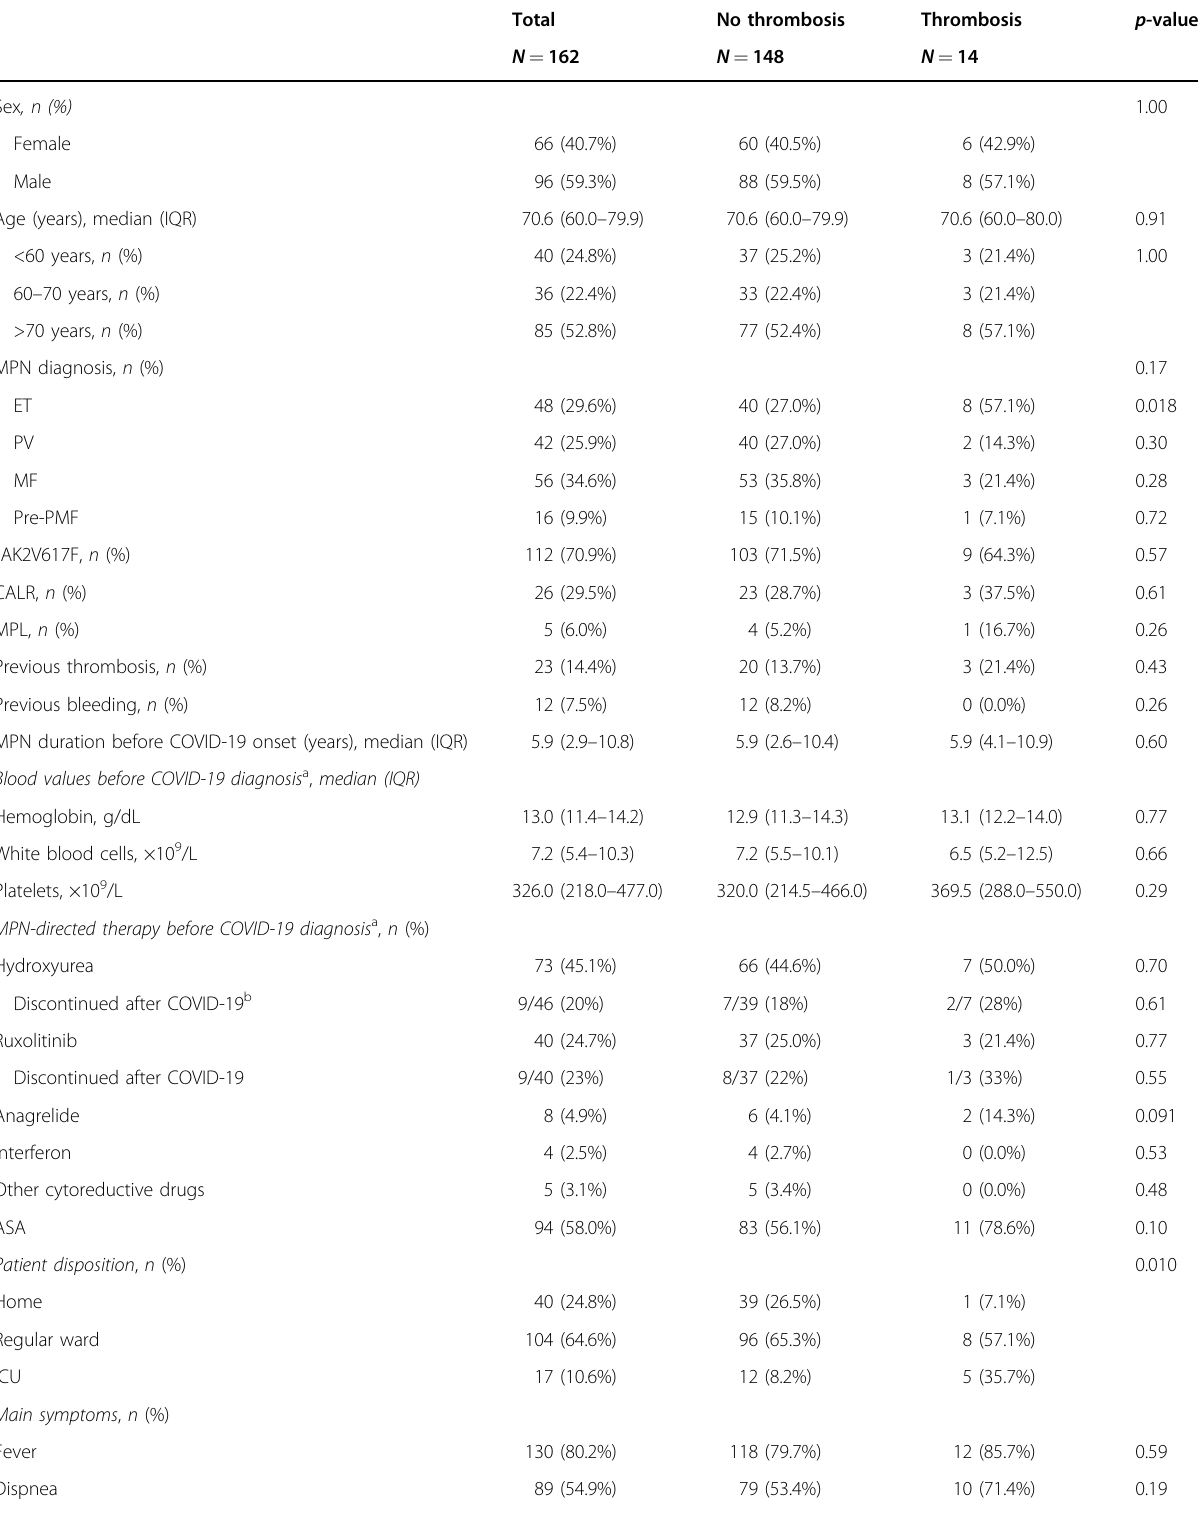
Table 3 Univariate analysis for